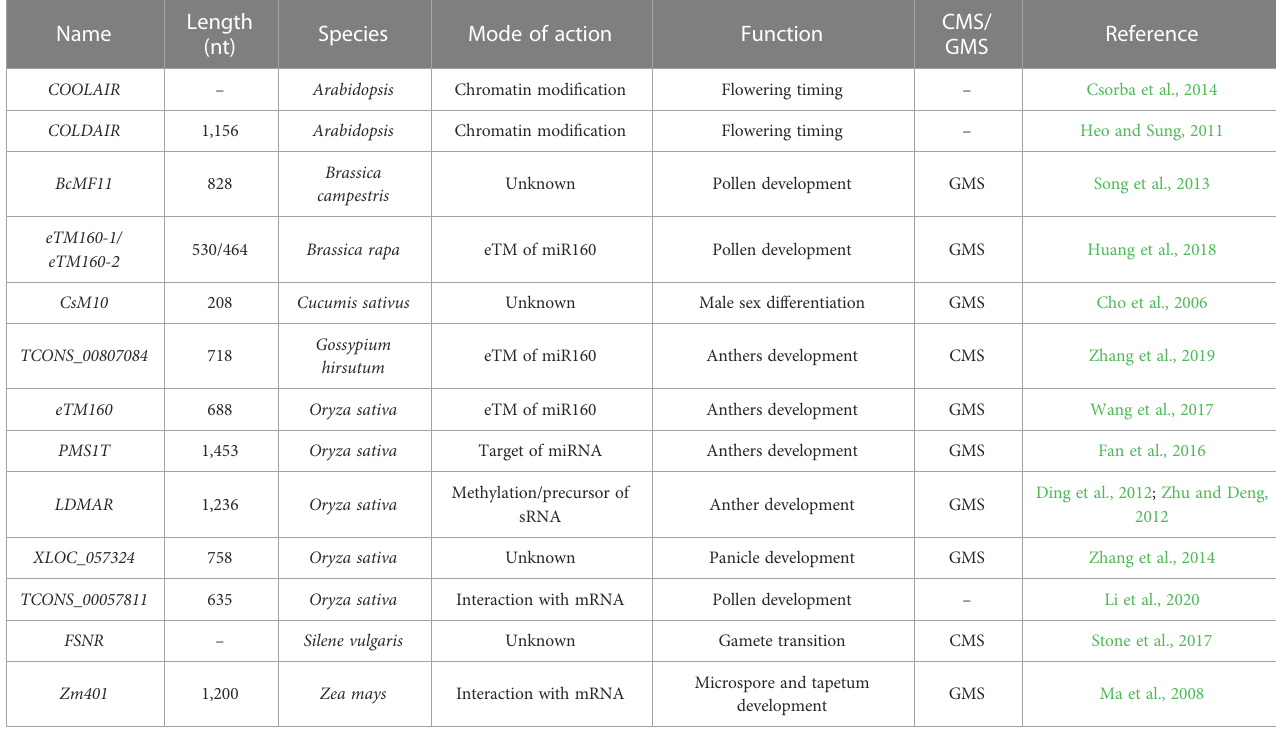
TABLE 1 Long non-coding RNAs (lncRNAs) involved in plant reproductive